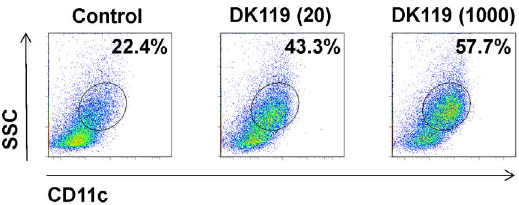
Figure 10. DK119 increases CD11c + cell populations from BMDCs. Bone marrow derived dendritic cells (BMDCs) were seeded in concentrations of 2.5 6 10 5 cells/ml and treated with 5 6 10 6 CFU/ml of DK119 or 2.5 6 10 8 CFU/ml for 2 days. The cells within a circle are CD11c positive cells and their percentages indicated. A representative figure in each is shown from three independent experiments. Control: No DK119, DK119 (20): 5 6 10 6 CFU/ml of DK119, DK119 (1000): 2.5 6 10 8 CFU/ml of DK119.